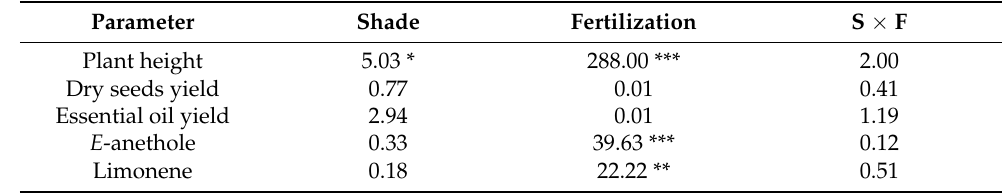
Table 6. Statistical significance of F ratios from the analysis of variance for growth parameters and essential oil main components of anise.